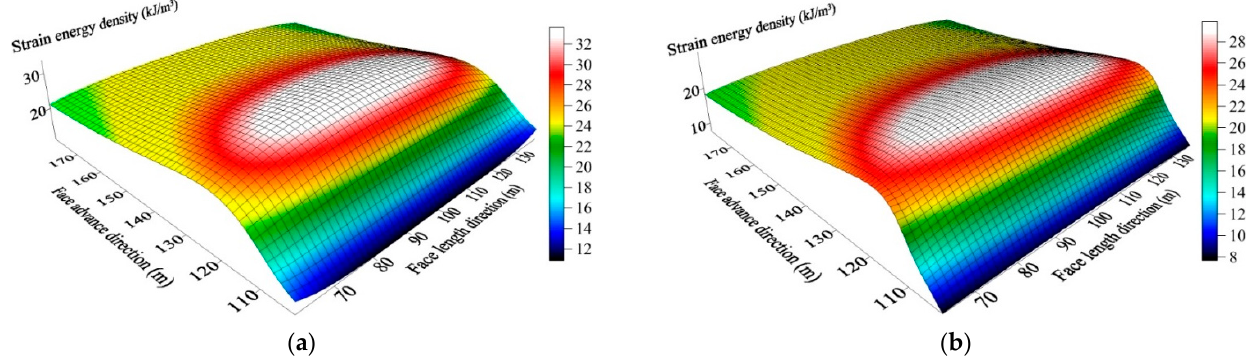
Figure 14. Spatial distribution of the strain energy in the main roof. ( a ) before roof rupture; ( b ) after roof rupture.